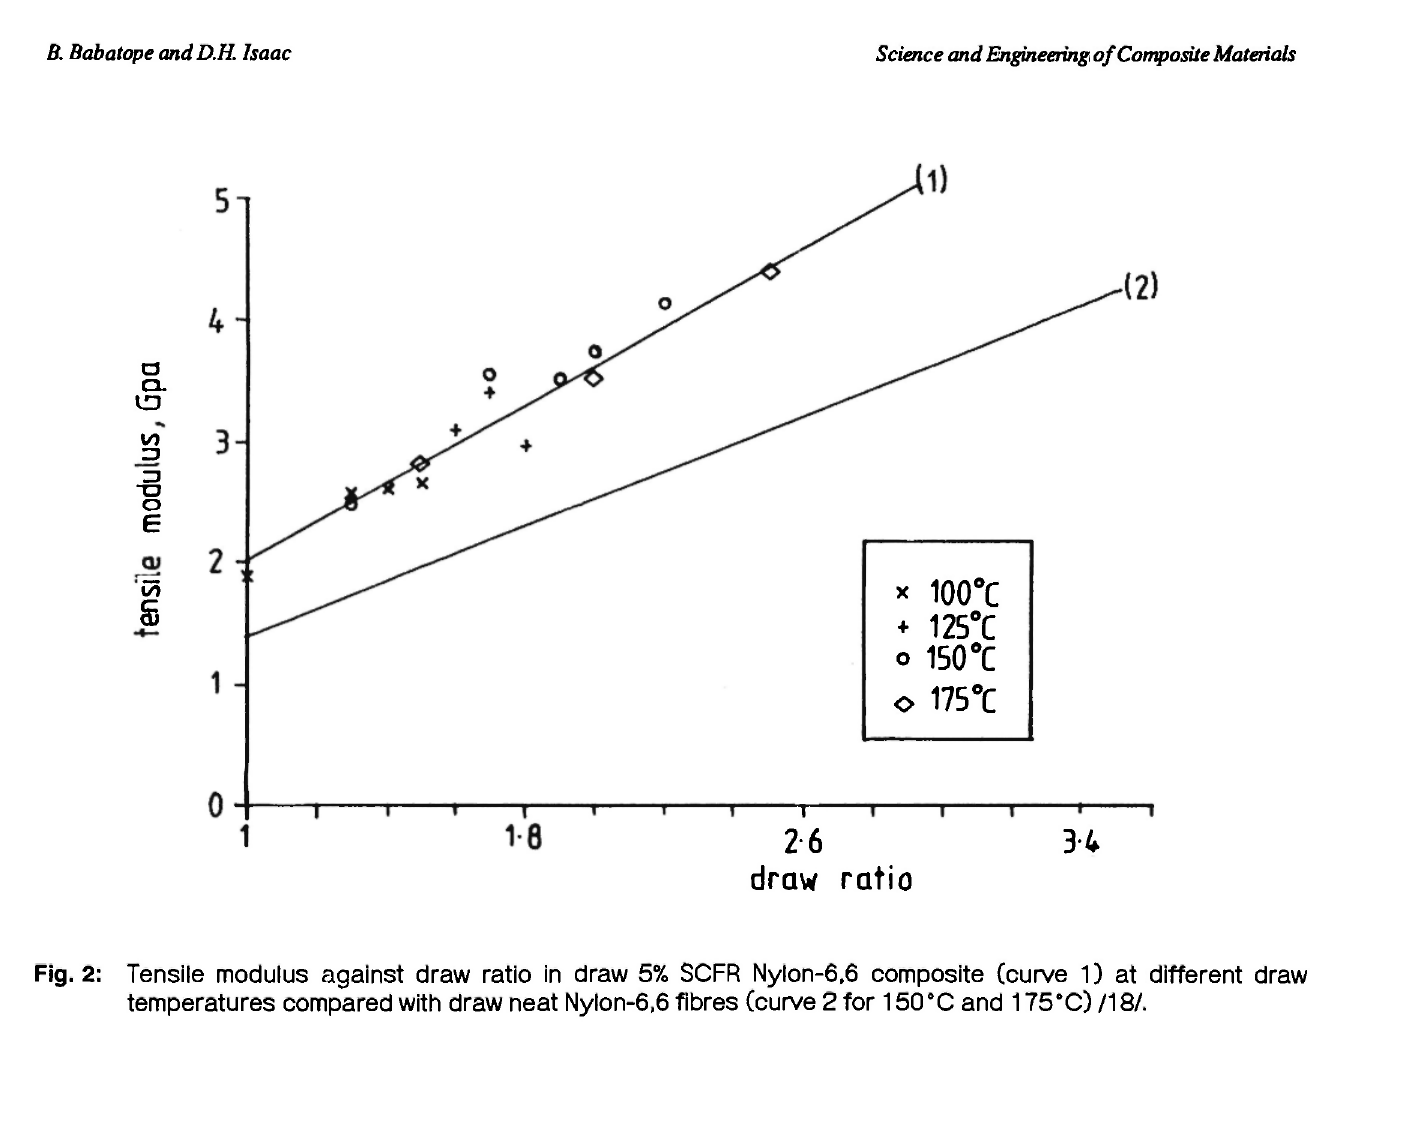
Fig. 2: Tensile modulus against draw ratio in draw 5% SCFR Nylon-6,6 composite (curve 1) at different draw temperatures compared with draw neat Nylon-6,6 fibres (curve 2 for 150'C and 1 75°C)